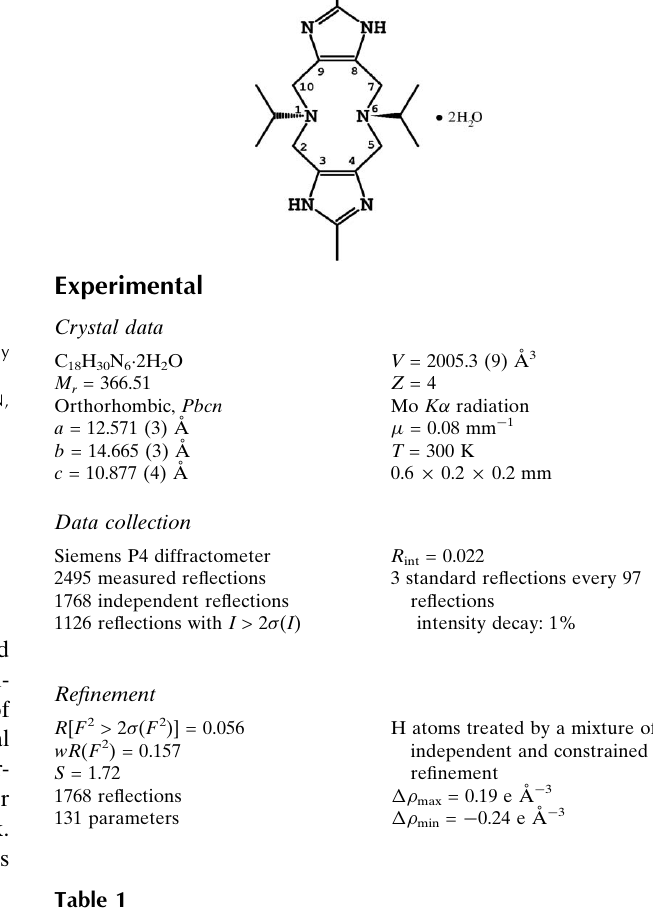
Hydrogen-bond geometry (A˚ , (cid:5)